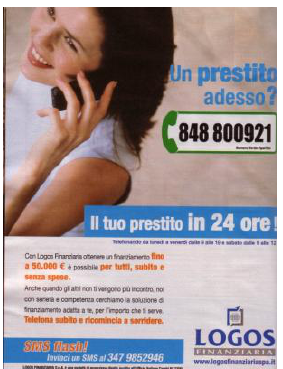
Figure A7. Own selected picture women smiles more than men.